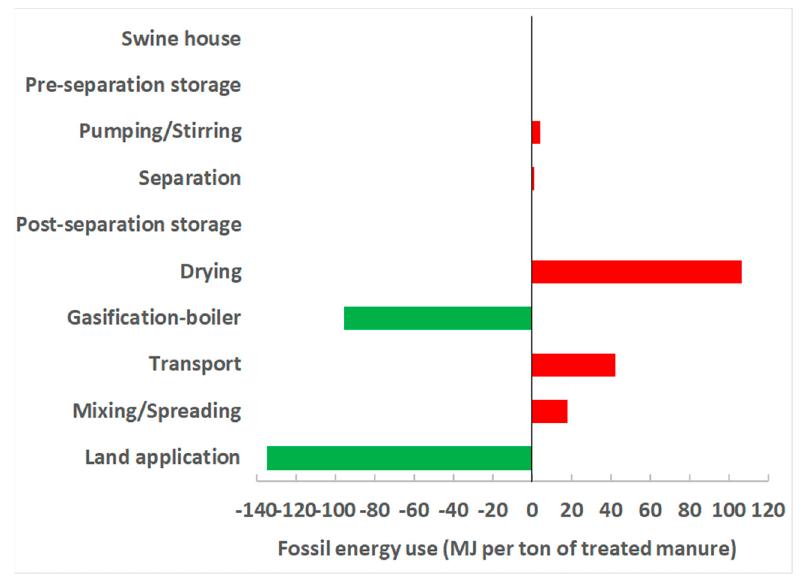
Figure 3. The net contribution of each stage to the cumulative fossil fuel energy use (MJ).